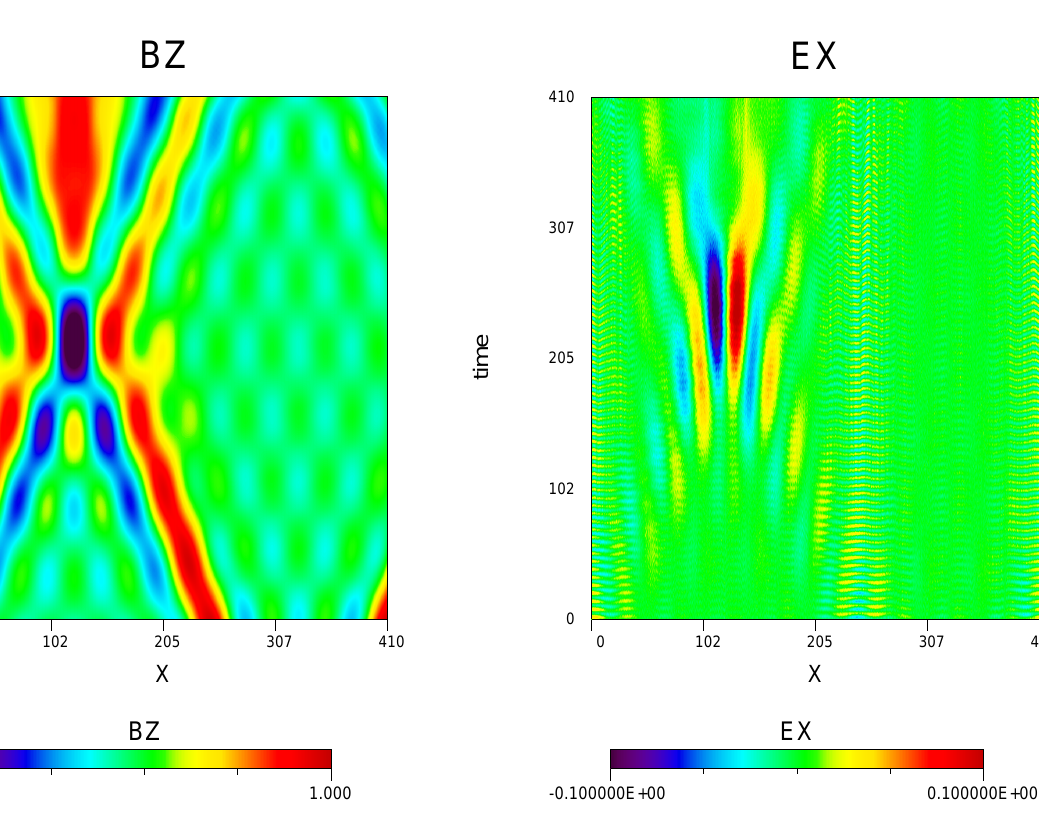
Fig. 1. AWC001(two wave packets). Temporal stack plot of the transverse magnetic field B Z (X,t) .